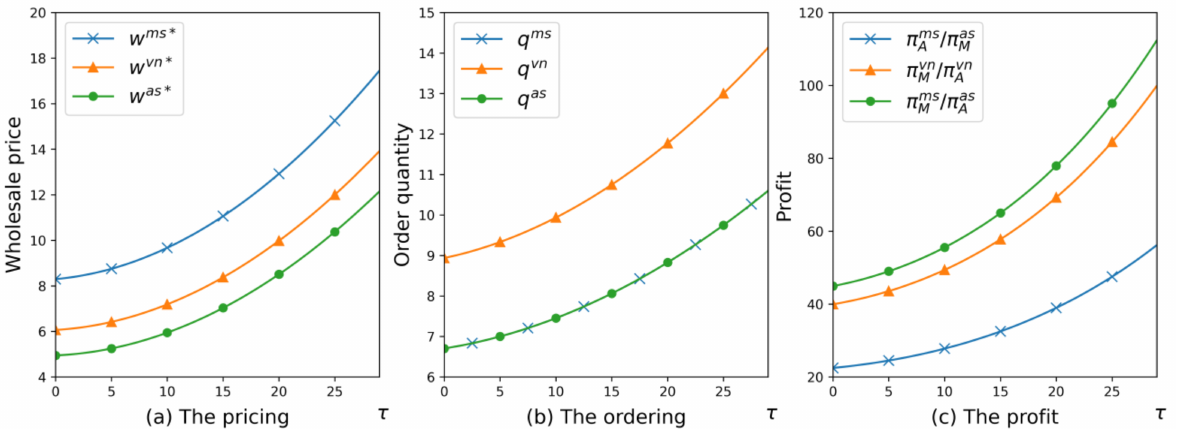
Figure 4. Impact of the consumer’s low carbon sensitivity coefficient in different power structures: ( a ) impact of the consumer’s low carbon sensitivity coefficient on the pricing; ( b ) impact of the consumer’s low carbon sensitivity coefficient on the ordering; ( c ) impact of the consumer’s low carbon sensitivity coefficient on the